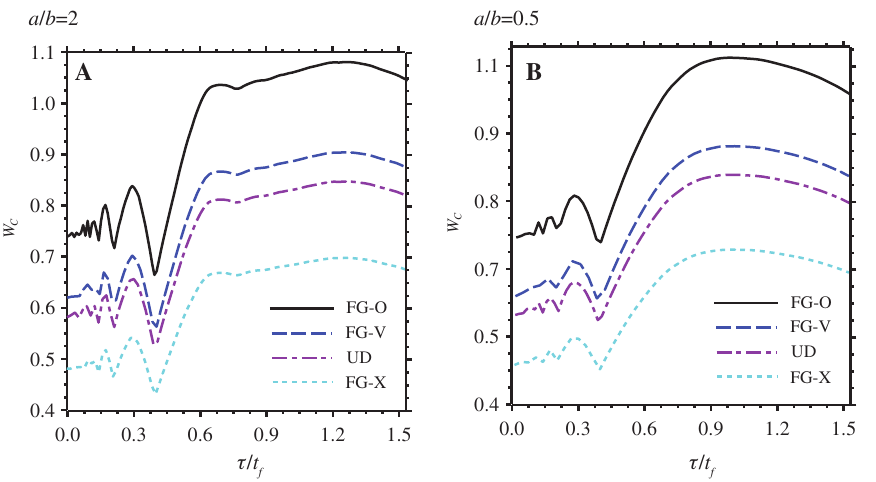
Figure 9 (A, B) The influence of the plate aspect ratio and CNT distributions on the maximum normalized dynamic center deflection of simply supported (SSSS) FG plates.